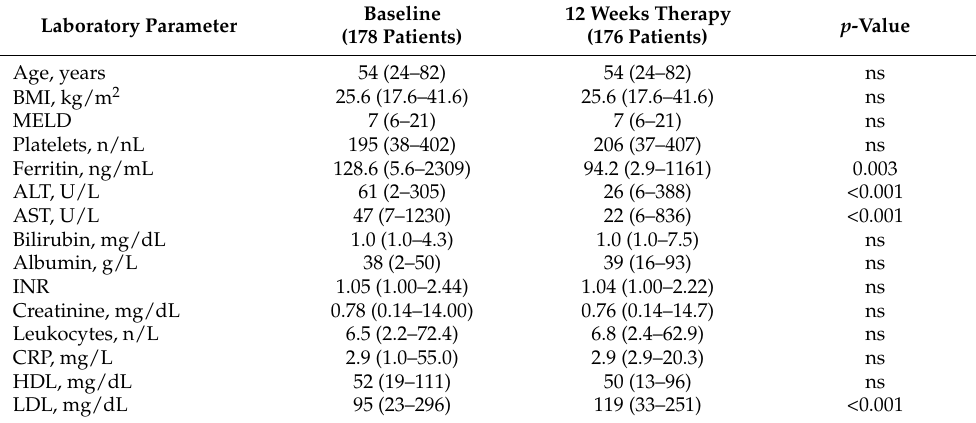
Table 1. Laboratory parameters of the patients at baseline and after 12 weeks of antiviral therapy (alanine amino transferase (ALT), aspartate aminotransferase (AST), body mass index (BMI), C- reactive protein (CRP), high-density lipoprotein (HDL), international normalized ratio (INR), low- density lipoprotein (LDL), model of end-stage liver disease (MELD), not significant (ns)). Laboratory Parameter